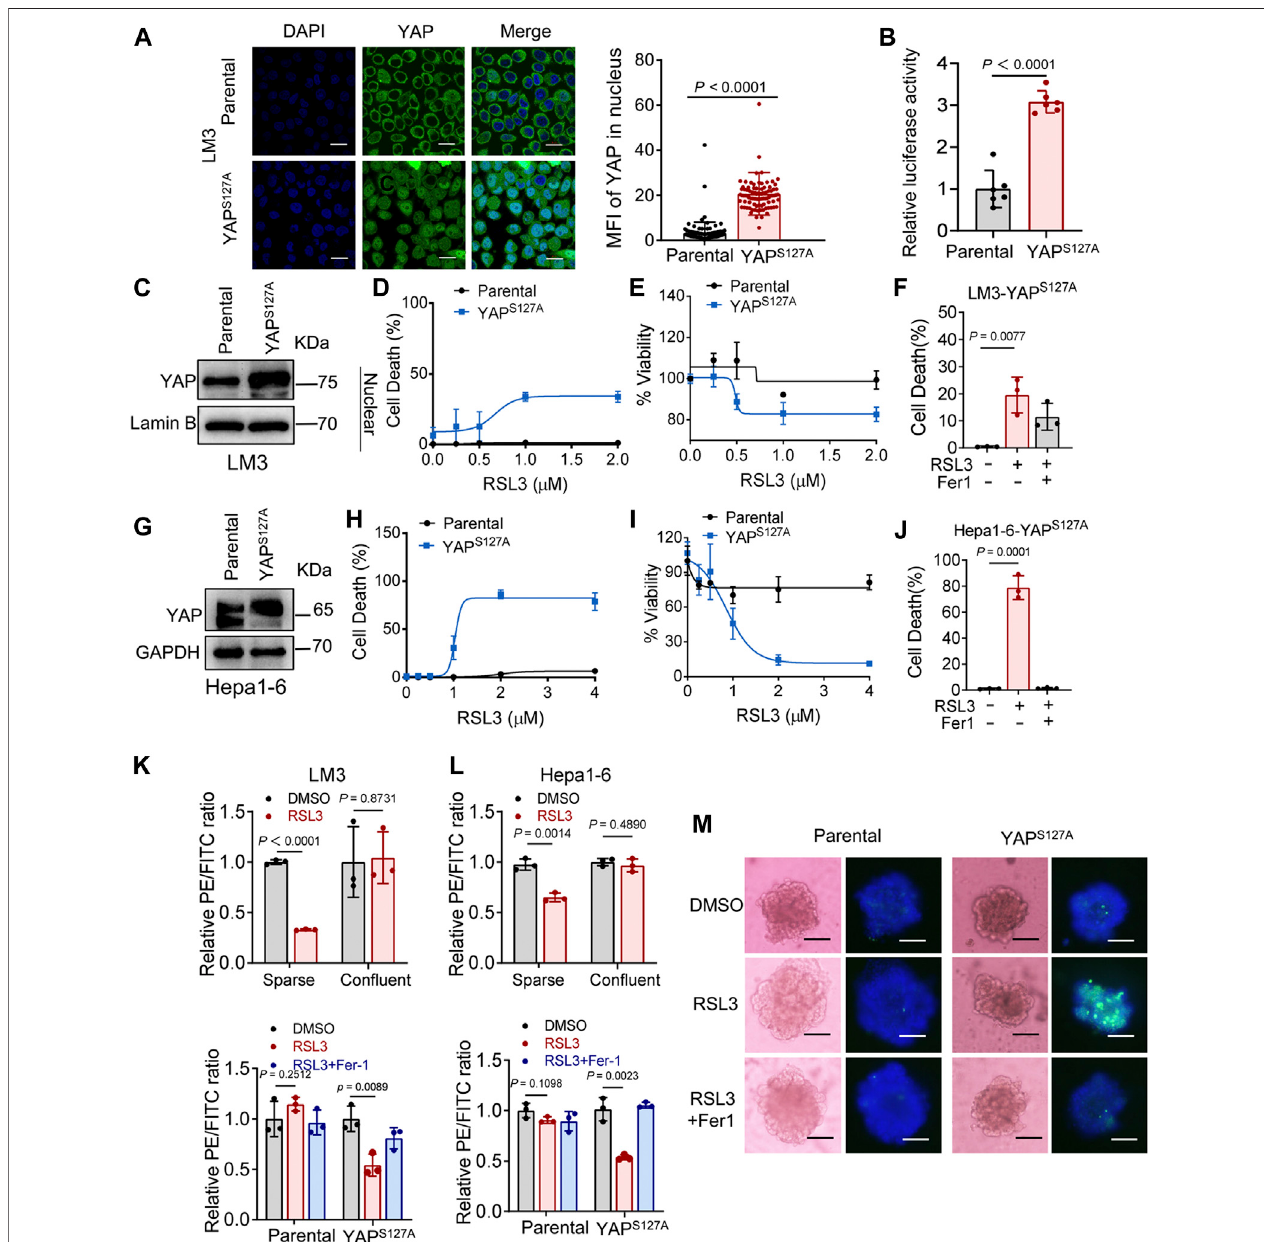
FIGURE 3 | YAP activation sensitizes ferroptosis in HCC cells. (A) LM3 cells were infected with retroviruses encoding Flag-YAP S127A . Localization of YAP (green) was determinedbyimmuno fl uorescence.Right,theexpressionofYAPinnucleuswasquanti fi edbyImageJ.Scalebars,20 μ m.Parental, n (cid:2) 99cellsfrom3images,YAP S127A , n (cid:2) 90 cellsfrom3images. (B) YAP/TEADtranscriptionalactivityincon fl uentLM3cellsexpressingYAP S127A wasmeasuredbyaluciferaseassayusingthe8xGTIIC-luciferasereporter. n (cid:2) 6 biologicallyindependentsamplespercondition. (C) LevelsofYAPinthenucleusofLM3cellswereanalyzedbywesternblot. (D,E) Con fl uentparentalLM3cellsandYAP S127A - overexpressing cells were treated with RSL3. Cell death was measured following 12-h treatment of RSL3 and cell viability was assayed following 18 h treatment of RSL3 with indicated concentrations. n (cid:2) 3 biologically independent samples per condition. (F) Con fl uent LM3-YAP S127A cells were treated with or without RSL3 (1 μ M) or Fer-1 (1 μ M) as indicated for 15 h. Cell death was measured. n (cid:2) 3 biologically independent samples per condition. (G) Levels of YAP in con fl uent parental Hepa1-6 cells and YAP S127A - overexpressing cellswere analyzed by Western blot. (H,I) Celldeath and cellviability in con fl uentparentalHepa1-6cellsand YAP S127A -overexpressingcellstreated with RSL3with indicated concentrations. (H) n (cid:2) 3 biologically independent samples per condition. (I) n (cid:2) 2 biologically independent samples per condition. (J) Cell death of con fl uent Hepa1-6- YAP S127A cellstreatedwithorwithoutRSL3(1 μ M)orFer-1(1 μ M)asindicatedfor15 h n (cid:2) 3biologicallyindependentsamplespercondition. (K) Up,lipidROSproductioninLM3 cells,culturedwithindicatedcelldensityandtreatedwith2 μ MRSL3for6 h.Bottom,lipidROSproductioninparentalandYAP S127A -overexpressingcon fl uentLM3cellstreatedwith 2 μ MRSL3for6 h,withorwithoutFer-1(1 μ M). (L) Up,lipidROSproductioninHepa1-6cells,culturedwithindicatedcelldensityandtreatedwith2 μ MRSL3for6 h(thedecreasing PE/FITCratiomeansincreasinglipidperoxidation).Bottom,lipidROSproductioninparentalandYAP S127A -overexpressingcon fl uentHepa1-6cellstreatedwith2 μ MRSL3for6 h, withorwithoutFer-1(1 μ M). n (cid:2) 3biologicallyindependentsamplespercondition. (M) Three-dimensionalspheroidsgeneratedfromparentalandYAP S127A -overexpressingLM3cells were treated with 2 μ M RSL3 for 20 h. Dead cells were stained by SYTOX green, while all nuclei were stained with Hoechst 33342 (blue). Scale bars, 200 μ m.